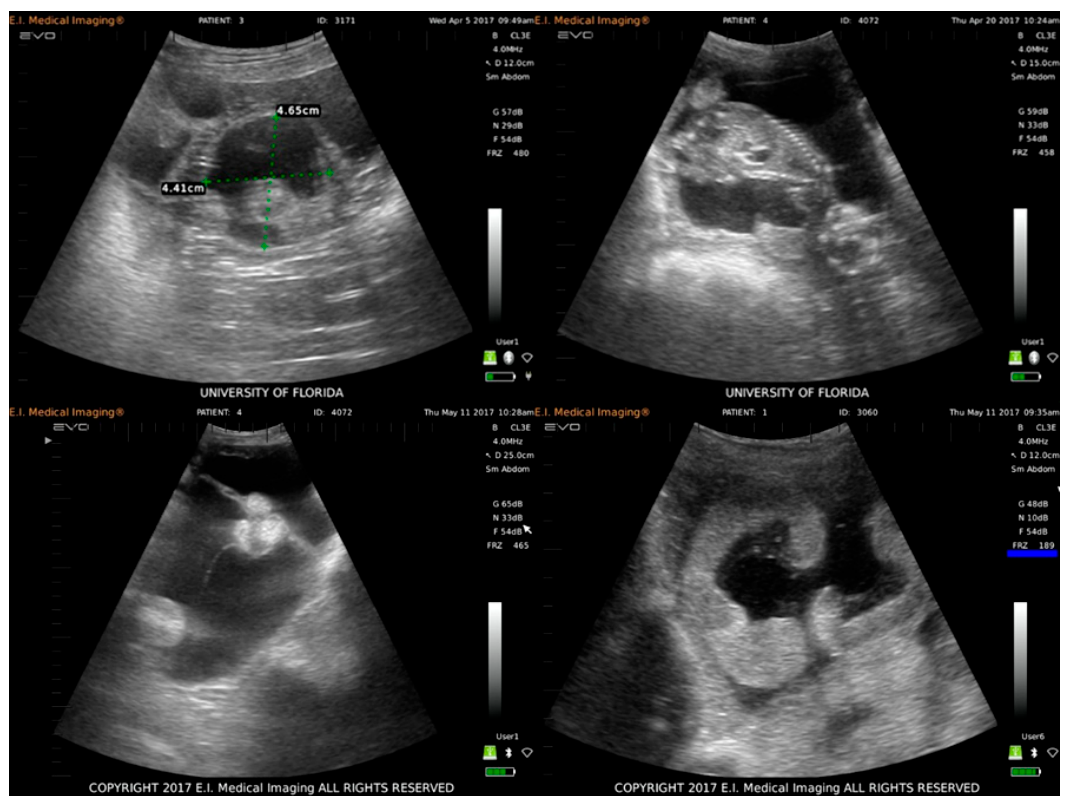
Figure 1. Ultrasound images of infected and control ewes taken during weekly transabdominal ultrasonography exams to monitor the viability and development of all fetuses during the infection study. Clockwise from top left: embryonic vesicle and embryo proper of a fetus from an infected animal one week post-infection (PI); lateral image of a fetus from an infected animal at four weeks PI (heart, ribcage, spine, and head are easily visualized); healthy placentomes (hyperechoic crescent-shaped object) and a normal amount of amniotic fluid in uterus of a control ewe at seven weeks PI; excess amniotic fluid accumulation (hydramnion), shrunken and misshapen placentomes (hyperechoic cluster of three round objects) consistent with hydramnion of one infected ewe at seven weeks PI.